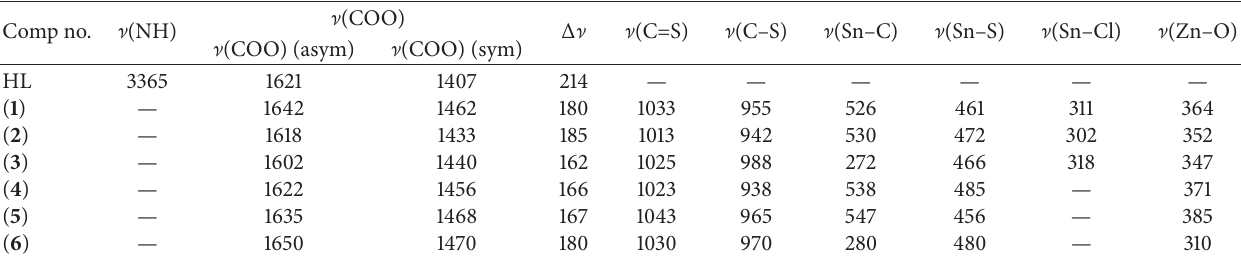
Table 2: IR spectral data (cm − 1 ) of heterobimetallic complexes with sarcosine. Comp no.